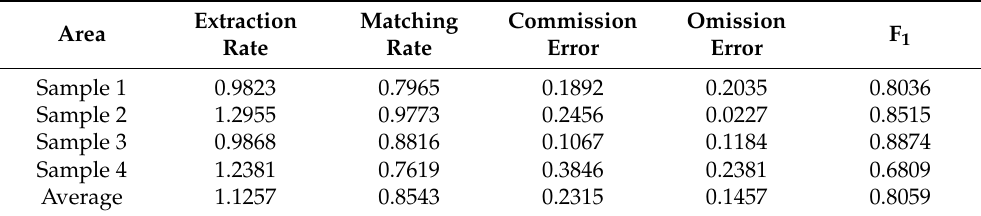
Table 2. The accuracy indicators of street tree segmentation